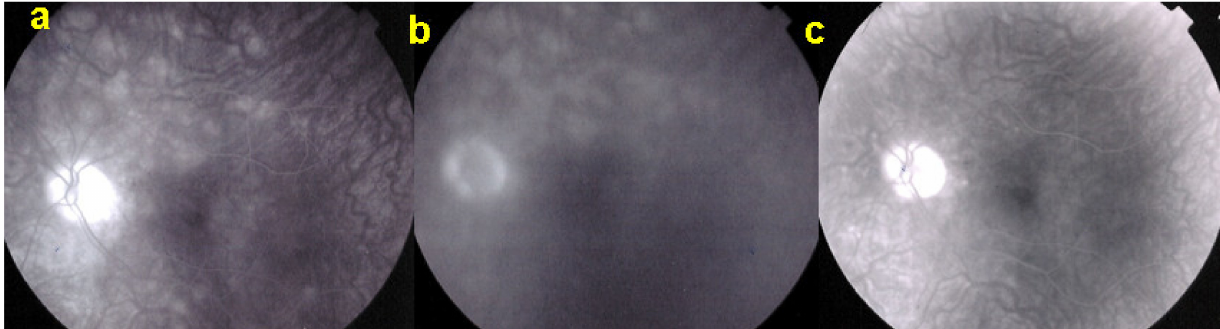
Figure 19. FA pictures of MFC at presentation ( a ), after 1 month ( b ) and 4 months ( c ). Patchy hyperfluorescent areas are seen at presentation around optic disc and along temporal superior arcade, indicating staining of retina caused by ischaemia of outer retina ( a ), still present at 1 month ( b ), almost resolved after 4 months ( c ).